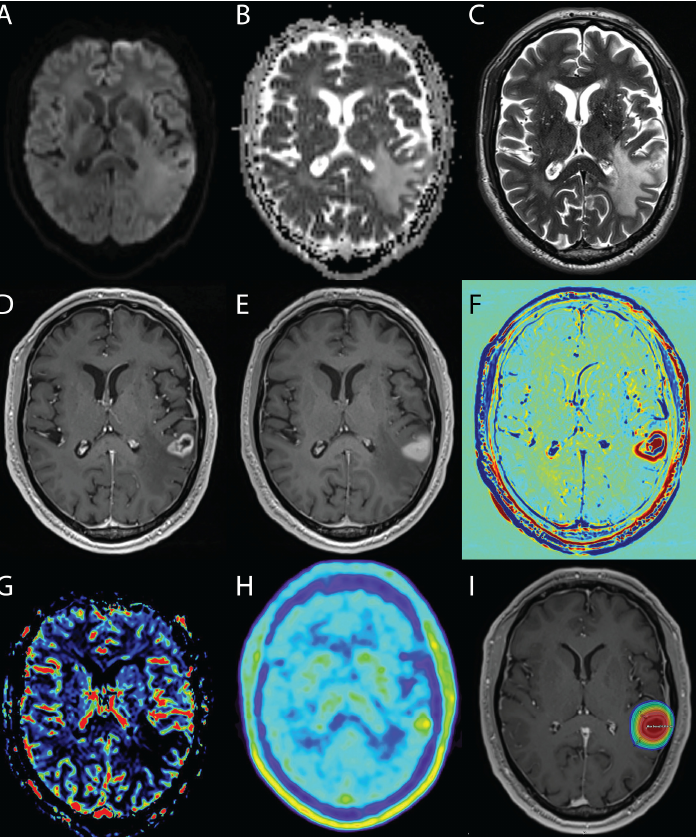
Figure 2. Example of radionecrosis in the parietal lobe of the left hemisphere after radiosurgery of a metastasis from non-small-cell lung cancer with 20 Gy on the 80% PTV marginal isodose: no dif- fusion restriction on diffusion-weighted images, the mean ADC in radionecrosis is not significantly different between the enhancing area and the neighboring area ( A , B ), non-correlation between the boundaries of the lesion seen on enhanced T1-weighted and T2-weighted imaging (“T1/T2 mis- match”) ( C ), non-specific morphological appearances of contrast enhancement in post-contrast T1- weighted images ( D ), which increases diffusely after 80 min in the delayed contrast extravasation MRI ( E ), as the contrast agent accumulates over time in necrotic tissue, color-coded in red in the treatment response assessment map (TRAM) ( F ), decreased rCBV as a result of occlusive vasculopa- thy leading to ischemia ( G ) and low tracer uptake in in the 18 F-FET-PET examination ( H ). The lesion is located within the high dose area of the radiation therapy ( I ). 3.3. Evaluation of Treatment Response by MRI Due to the expected high rate of tumor progression or treatment effects after radio- therapy, monitoring for radionecrosis or tumor recurrence is crucial. The determination